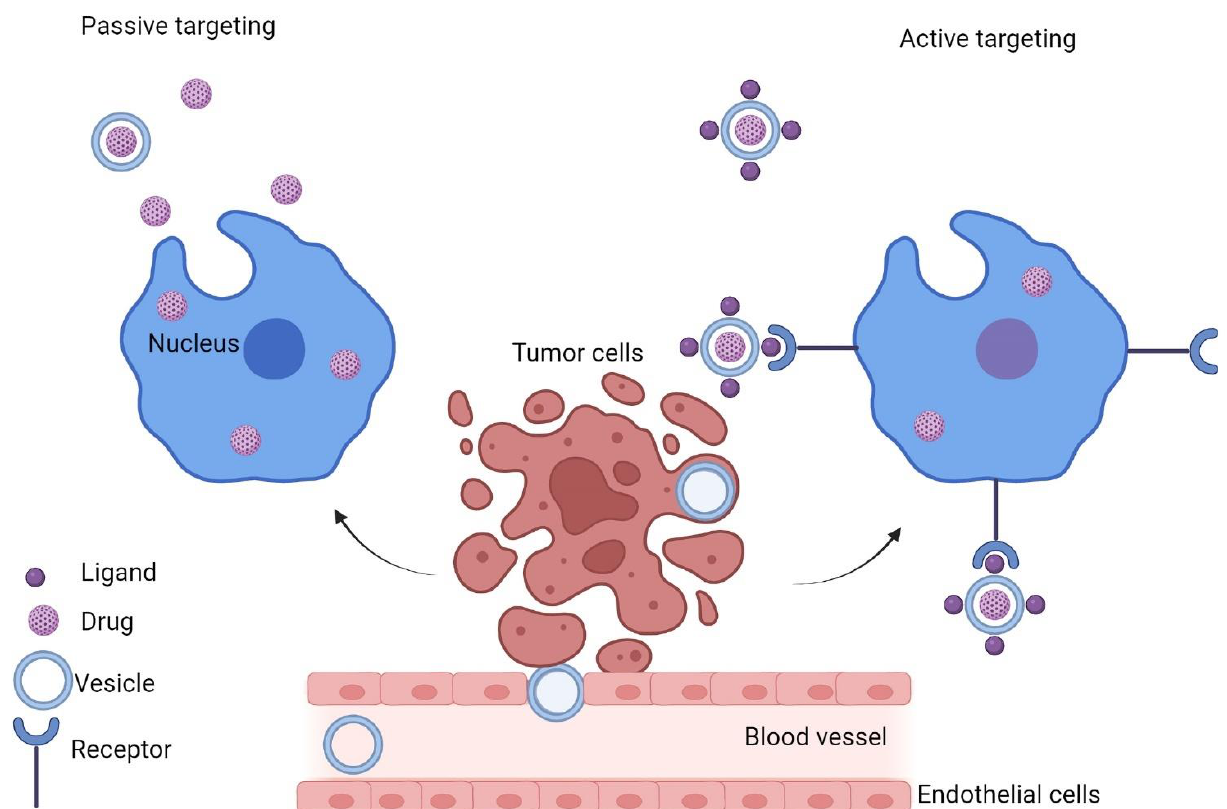
Figure 1. Passive and active